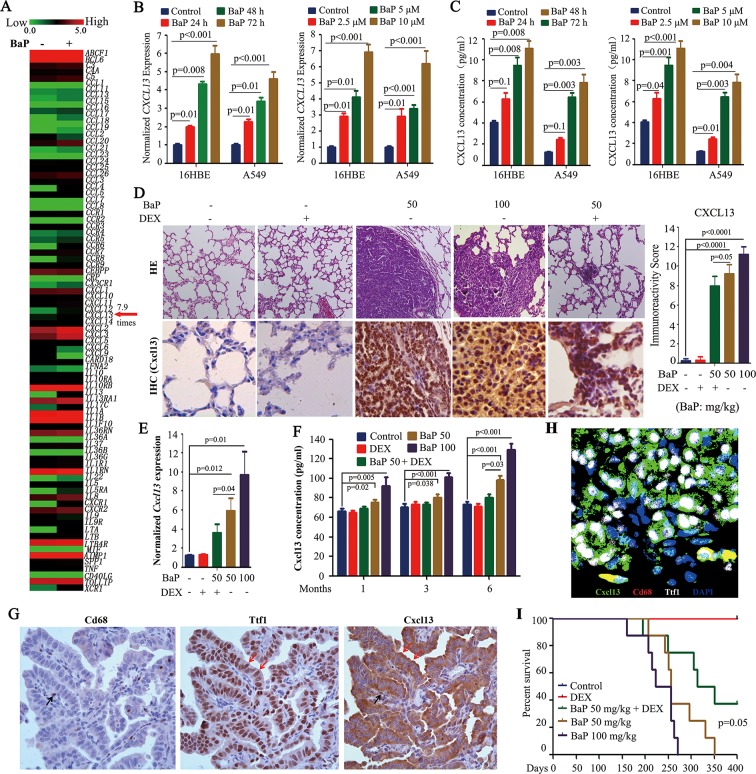
Benzo(a)pyrene (BaP) induces CXCL13 in vitro and in vivo.(A) A PCR array analysis of the expression of 84 cytokines/chemokines in 16HBE normal lung epithelial cells treated with 1 μM BaP for 30 days. (B) The cells were treated with BaP at 10 μM for indicated time points or with the indicated concentrations for 72 hr, and CXCL13 expression was assessed by real-time RT-PCR. The experiments were conducted in triplicate and repeated three times. The error bars represent the SD. (C) The cells were treated with BaP as described in (B), and the concentration of CXCL13 in the supernatants was evaluated by ELISA. (D) The A/J mice were treated with BaP and/or dexamethasone (DEX) for 5 weeks (see also Figure 2—figure supplement 1A) and sacrificed 6 months later. The lung tissues were isolated and analyzed by Hematoxylin and eosin (HE) staining or immunohistochemistry (IHC) using an anti-Cxcl13 antibody (left panel). The immunoreactivity score was calculated (right panel). (E) Cxcl13 expression was detected in the lung tissues by real-time PCR. (F) The concentration of Cxcl13 in mouse serum was assayed by ELISA. (G) IHC assays of mice’ lung tumor tissues using anti-Cd68, anti-Ttf1, and anti-Cxcl13 antibodies. (H) Immunofluorescence assay of mice’ lung tumor tissues using antibodies against Cxcl13 (green), Cd68 (red), and Ttf1 (white). 4',6-diamidino-2-phenylindole (DAPI) was used to stain the nucleus (blue). (I) The survival curves of the mice treated with BaP and/or DEX (n=8 for each group).